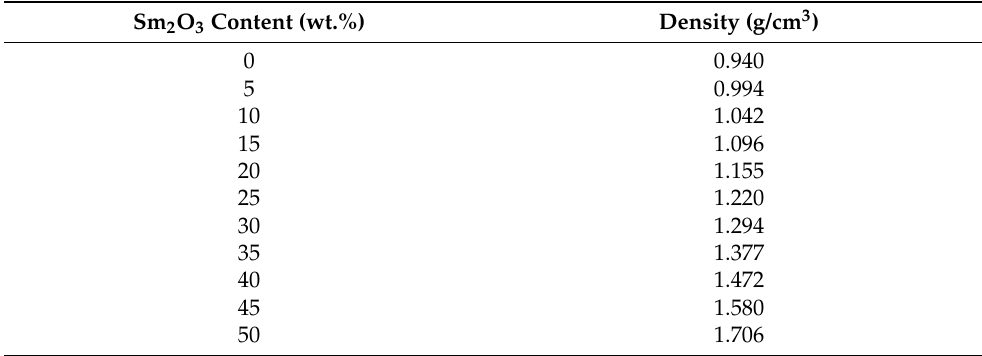
Table 1. Theoretical densities of UHMWPE composites containing varying Sm 2 O 3 contents in the range 0–50